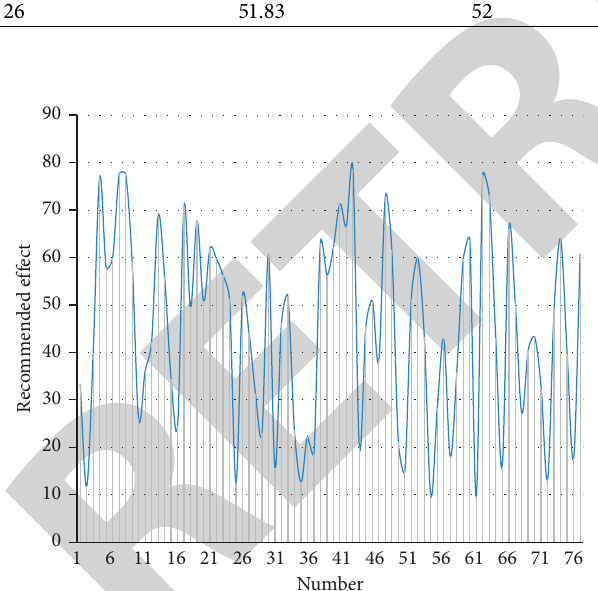
Figure 9: Evaluation of the recommendation effect of the hybrid music recommendation system incorporating music